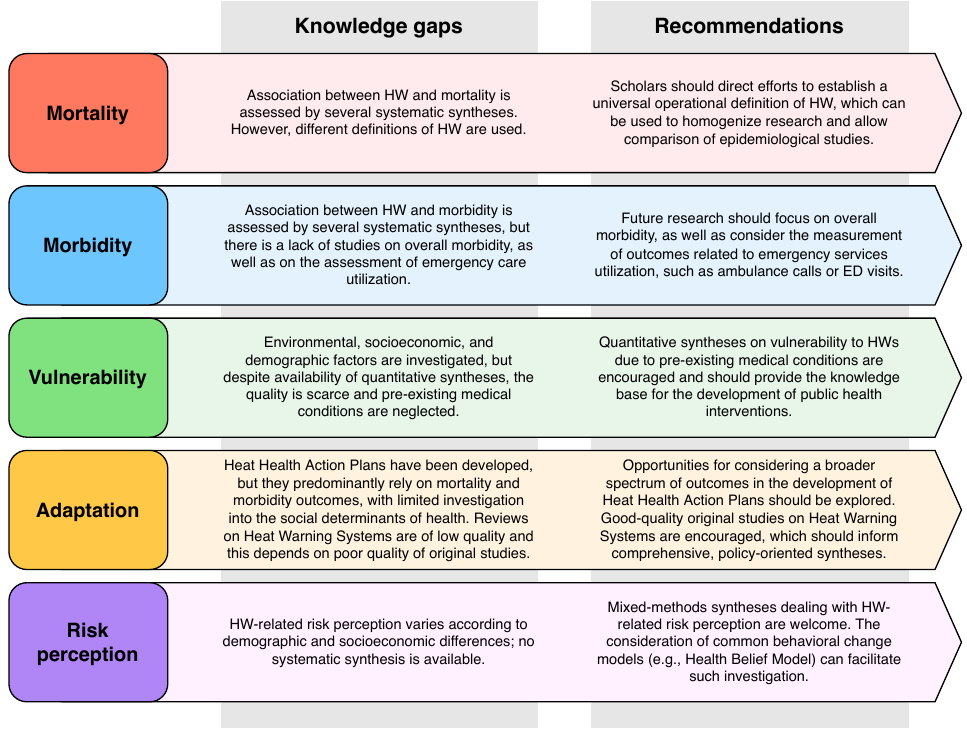
Figure 5. Knowledge gaps and recommendations emerged from the included